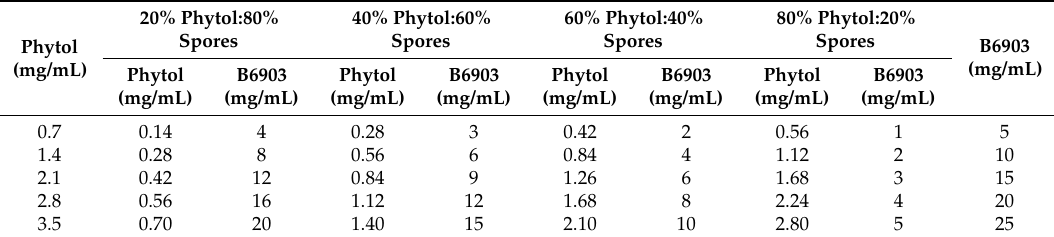
Table 3. Various concentrations of phytol and Beauveria bassiana isolate B6903 suspensions alone and in different proportions tested against Oligonychus